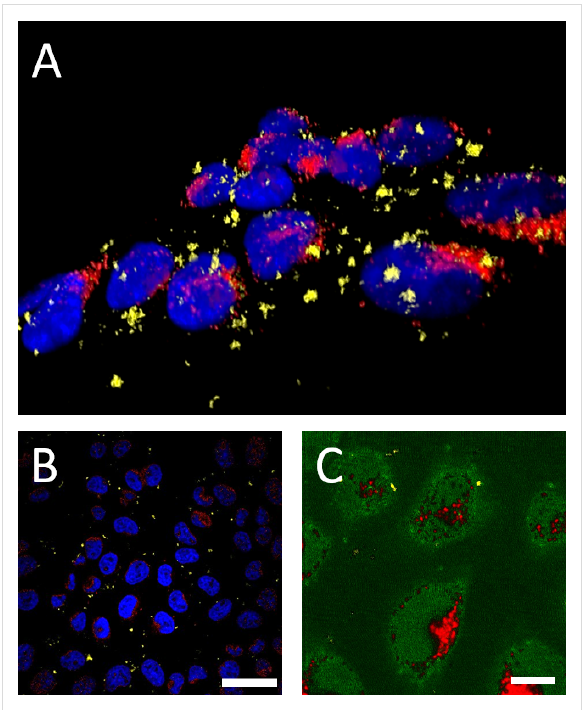
Figure 2: Confocal z-stack image of HeLa cells. (A) Volume view of the confocal z-stack showing blue: DAPI, red: endosomal marker Cy5, yellow: QD signal. (B) Spectral scan of one confocal plane (same colour code, scale bar 50 µm) (C) spectral unmixing of QD fluores- cence (575 nm) and Cy5-spectrum (red) highlighting no superposition between the QD and the Cy5 signal, scale bar 10